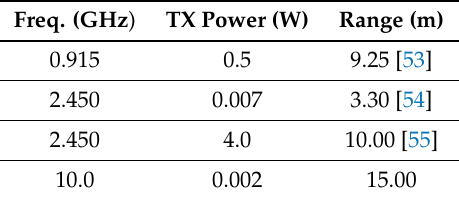
Table 1. State of the art RFID system performance